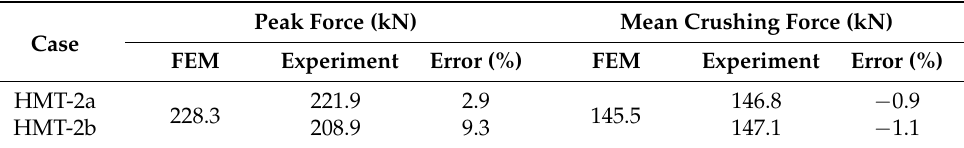
Table 6. Comparisons between FEM and experiments.